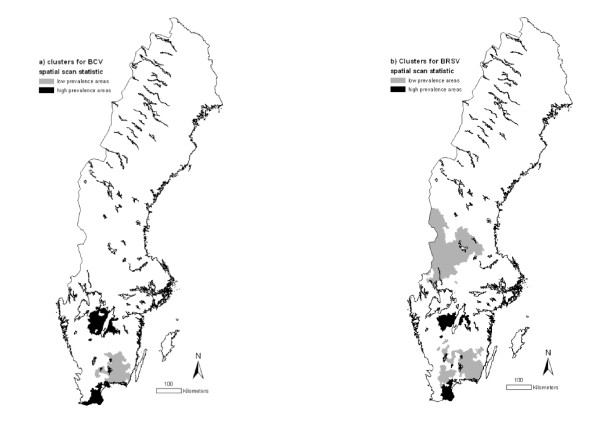
Areas with high or low prevalences of (a) BCV and (b) BRSV, obtained by a spatial scan statistic (Kulldorff, 1997), using the centroids of the three-digit postal code areas as coordinates (p < 0.01). © Lantmäteriverket Gävle 2010 Permission number I 2010/0055.